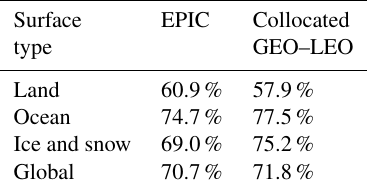
Table 3. Comparison between EPIC cloud fraction and collocated GEO–LEO results. Data used are the same as in Fig.